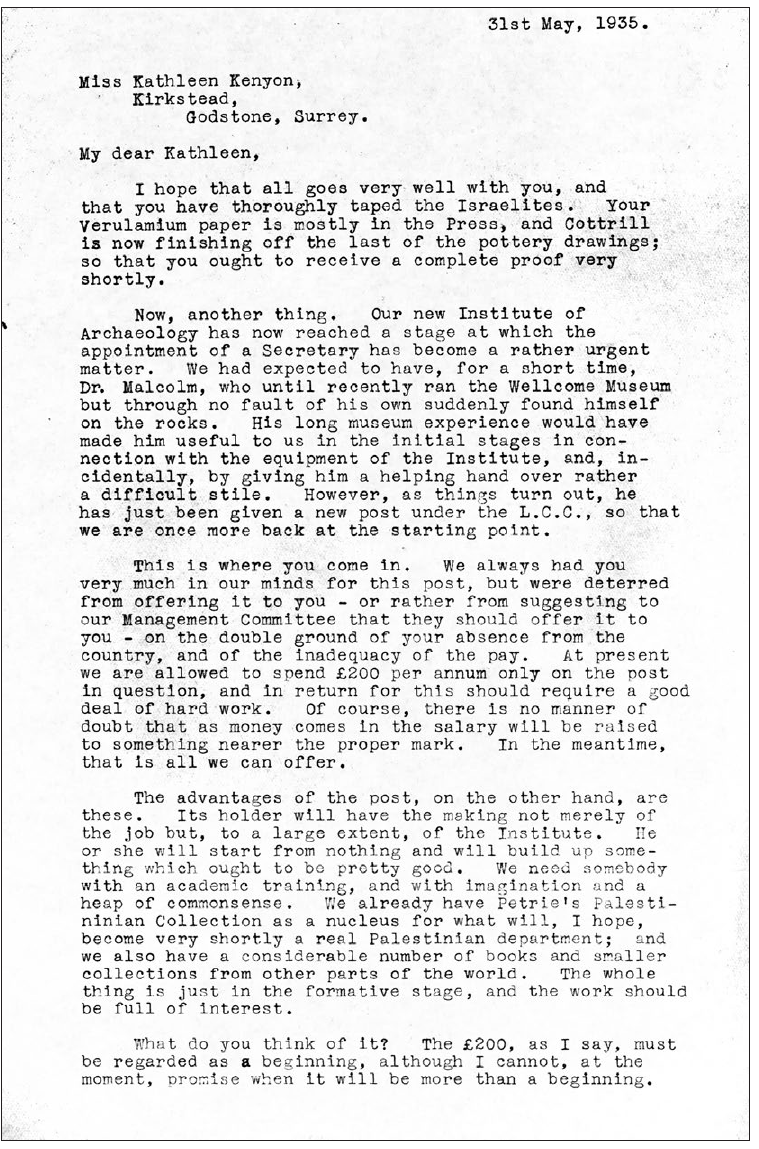
Figure 2: Letter from Wheeler to Kenyon, 31st May 1935, offering her the job of Secretary to the new Institute. Photo: Stuart Laidlaw. Reproduced with permission of the photographer. Institute of Archaeology Kenyon Staff